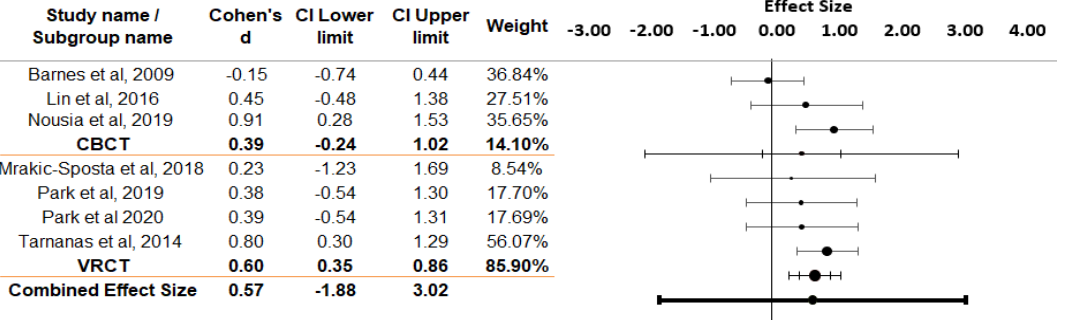
Figure 3. Forest plot of executive function (EF).